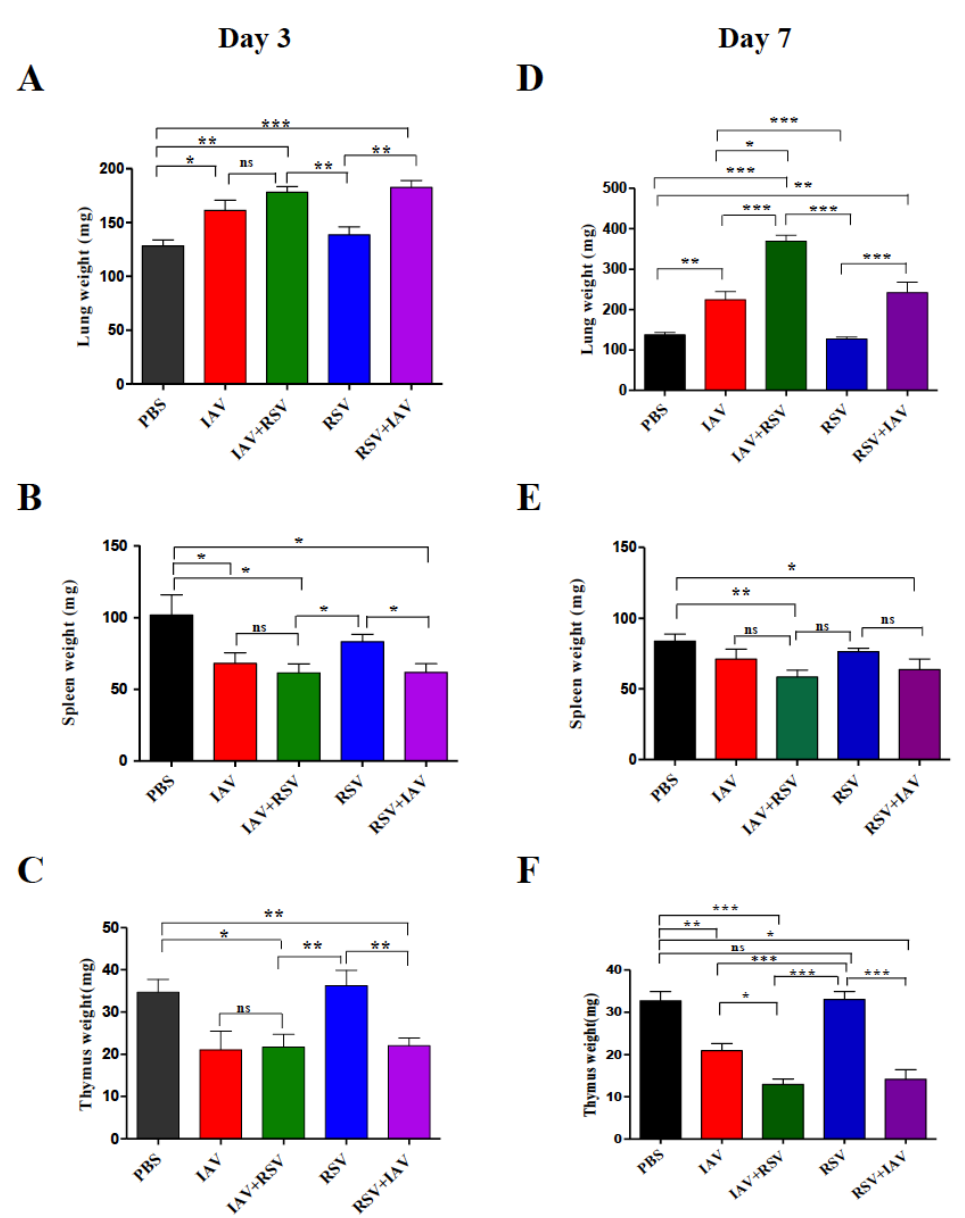
Figure 4. Co-infection leads to significant atrophy of the spleen and thymus, and an increase in lung weight. On day 3 or 7 post-infection, mice were sacrificed, and lung ( A , D ), spleen ( B , E ) and thymus ( C , F ) were excised and weighed. Results represent mean pooled values +/ − SEM from three independent experiments. Asterisks denote significant differences among the control, co-infected and singly-infected groups; (* p < 0.05, ** p < 0.005, *** p < 0.0005); ns = not significant. Comparison among groups was performed using the nonparametric test (two independent variables: Mann – Whitney).